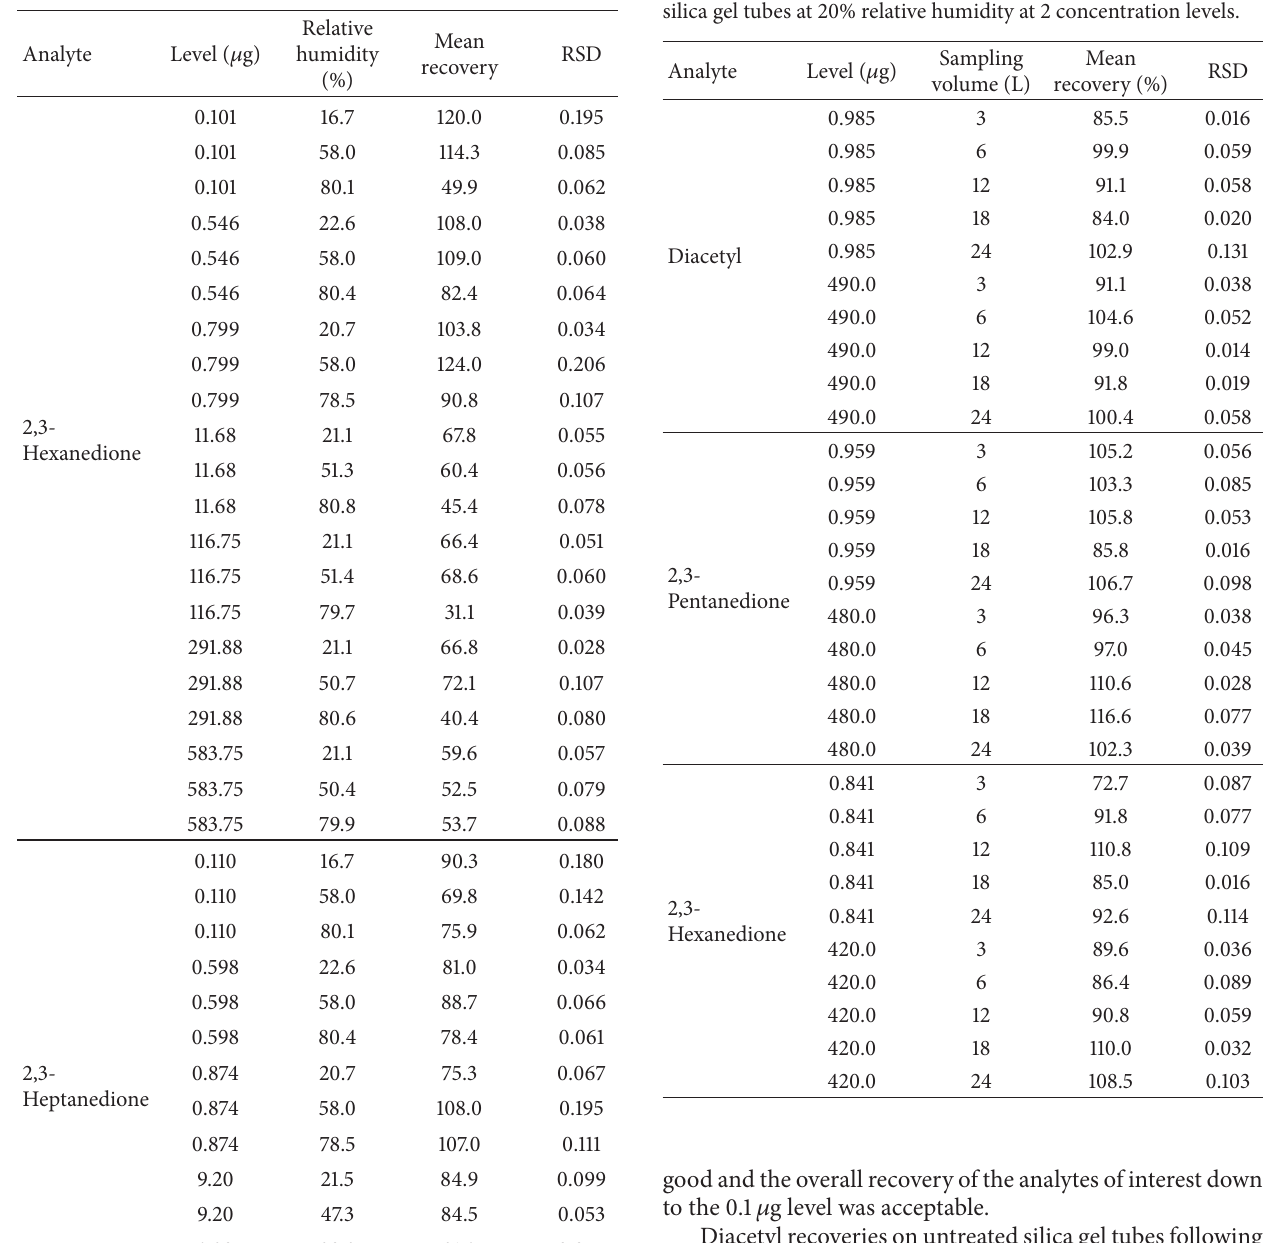
Table 8: Determination of air sampling capacity of o